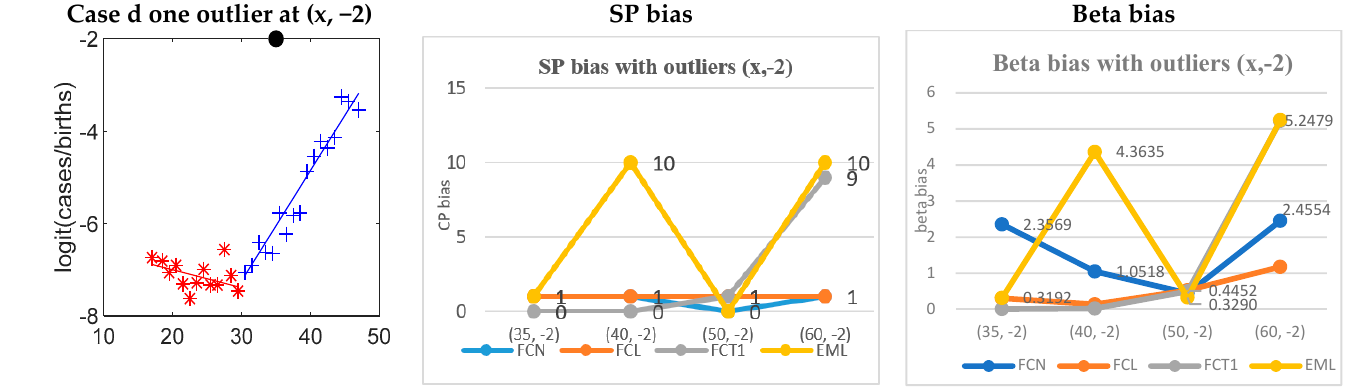
Figure 8. Comparisons of cases (a) and (d); data in case (d) are contaminated by one outlier (x, − 2), x = 35, 40, 50, 60, respectively.